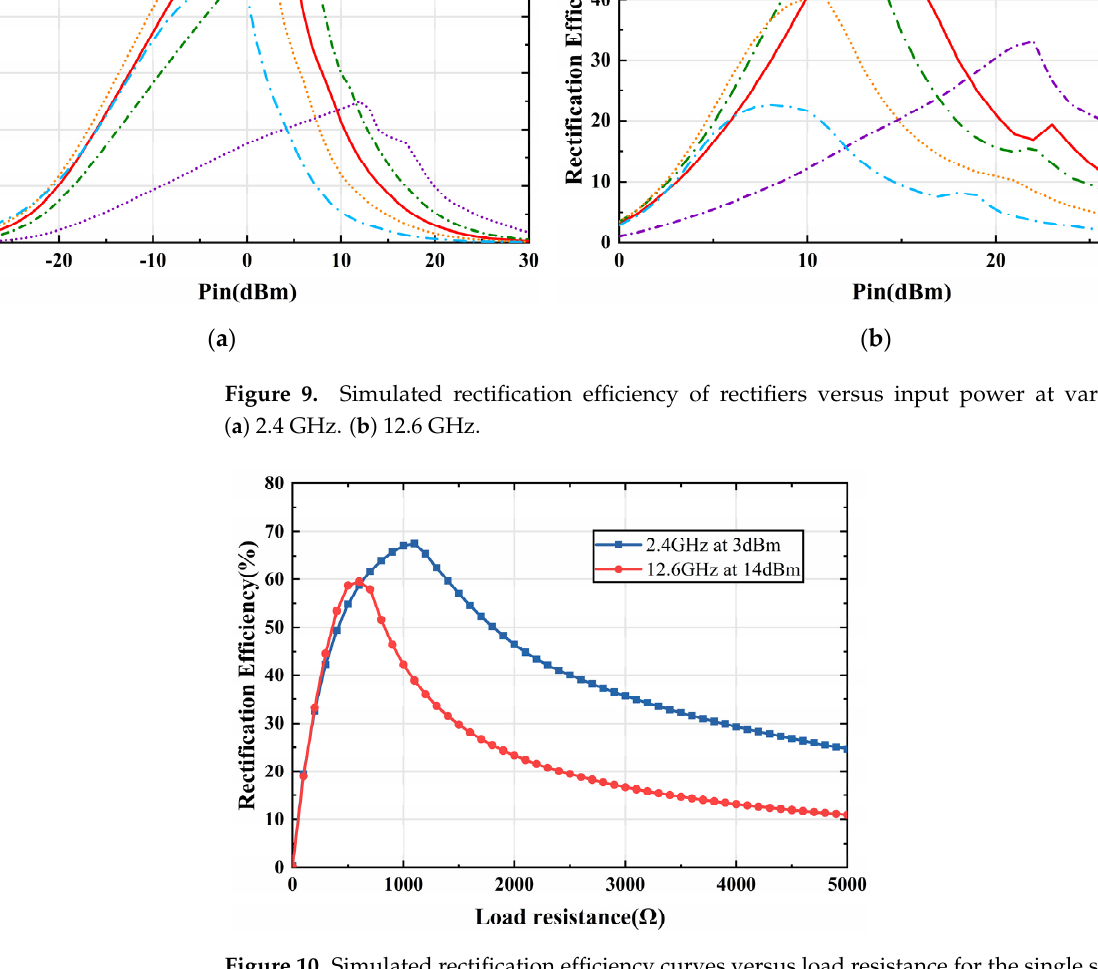
Figure 10. Simulated rectification efficiency curves versus load resistance for the single series diode rectifier and the voltage doubler rectifier.